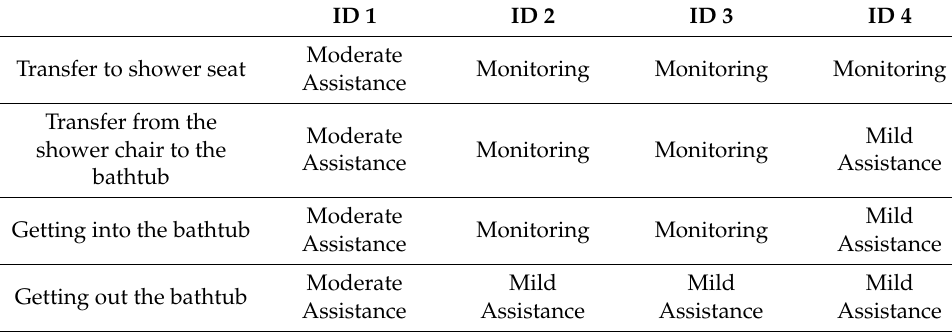
Table 2. The care requirements for bathing activities without